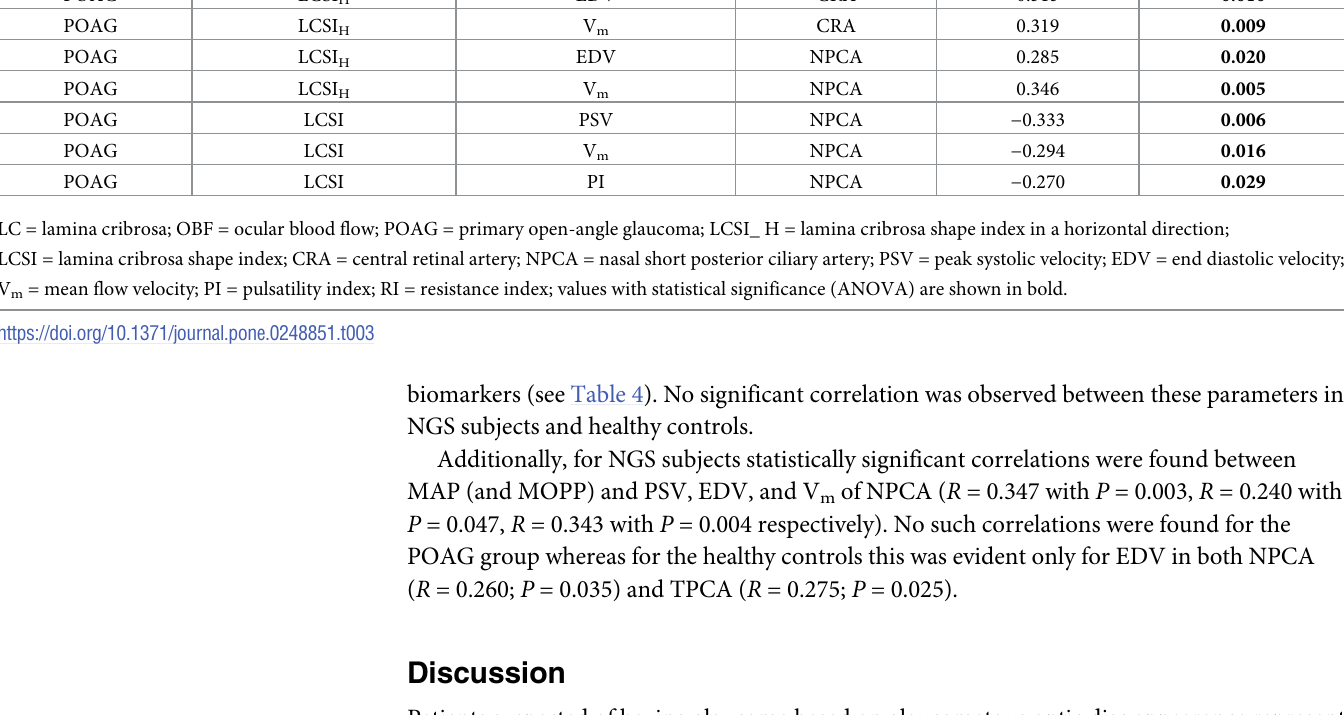
Table 3. Correlations corrected for age, central corneal thickness, intraocular pressure and the presence of hypertension between LC parameters and OBF biomarkers. Group